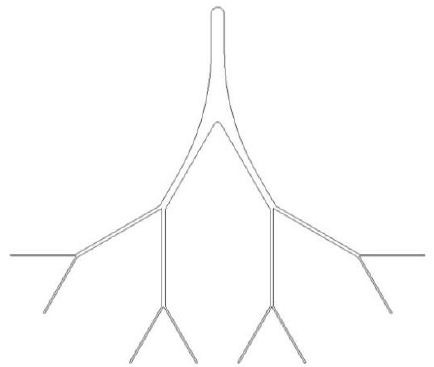
Figure 1. Symmetrical fractal treelike microchannel network.